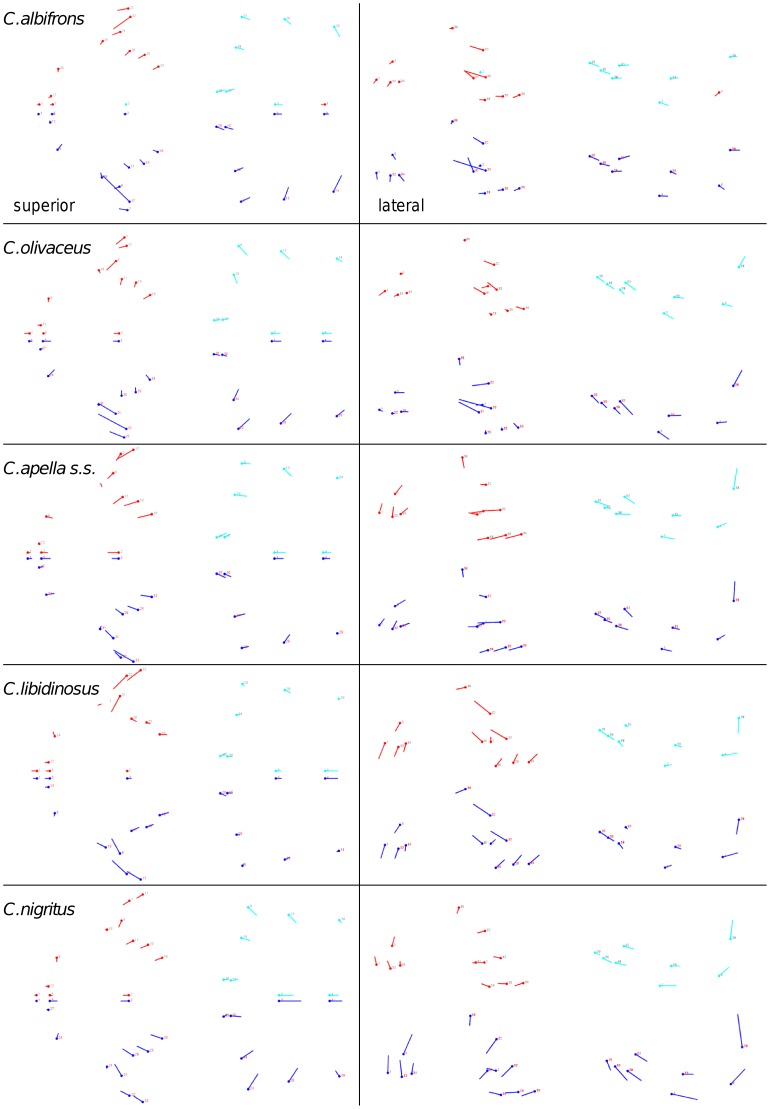
Shape change contained in the non-allometric face-cranial base PLS1 and the allometric PC1.Legend: oral-zygomatic PLS1 blocks colored in red and turquoise; PC1: landmark configuration colored in dark blue.